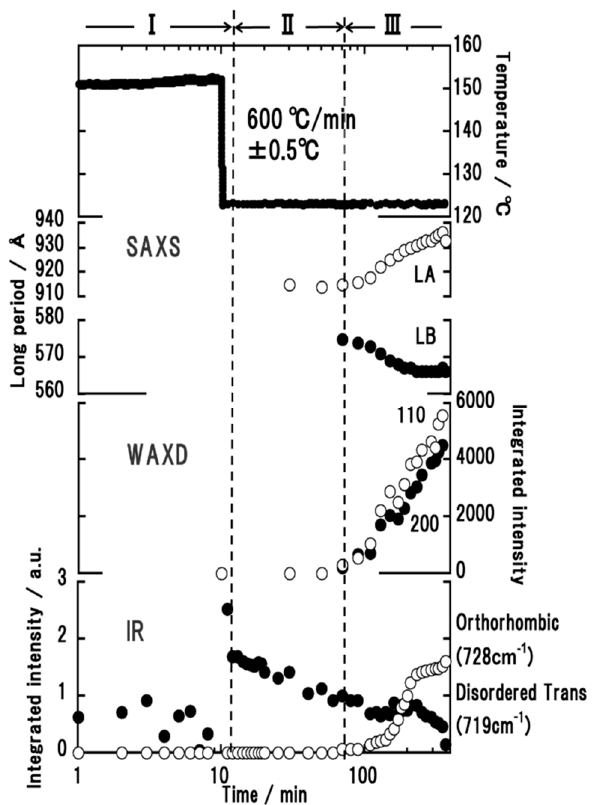
Figure 9. Time dependence of SAXS, WAXD, and IR data collected in the isothermal crystallization of high-density polyethylene.